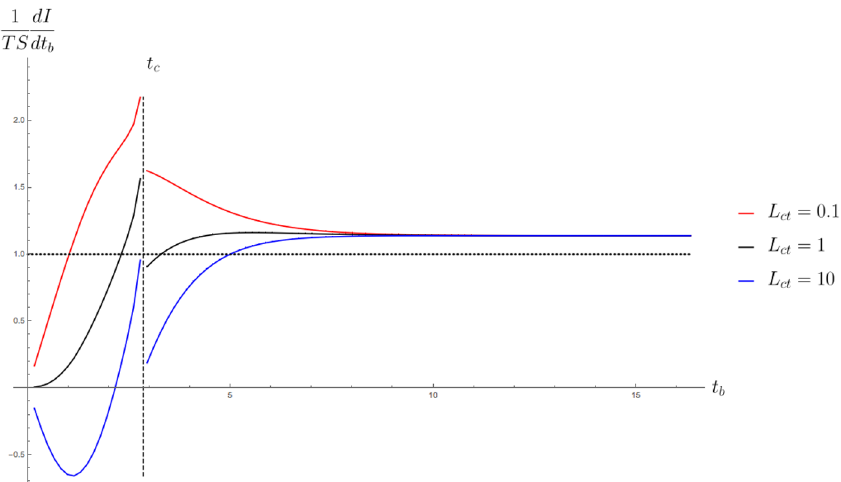
Figure 21 . Time dependence of the action complexity rate as a function of t b for various L ct with q = 0 , φ h = 0 . 7 , z h = 1 and ρ = 2 . 2